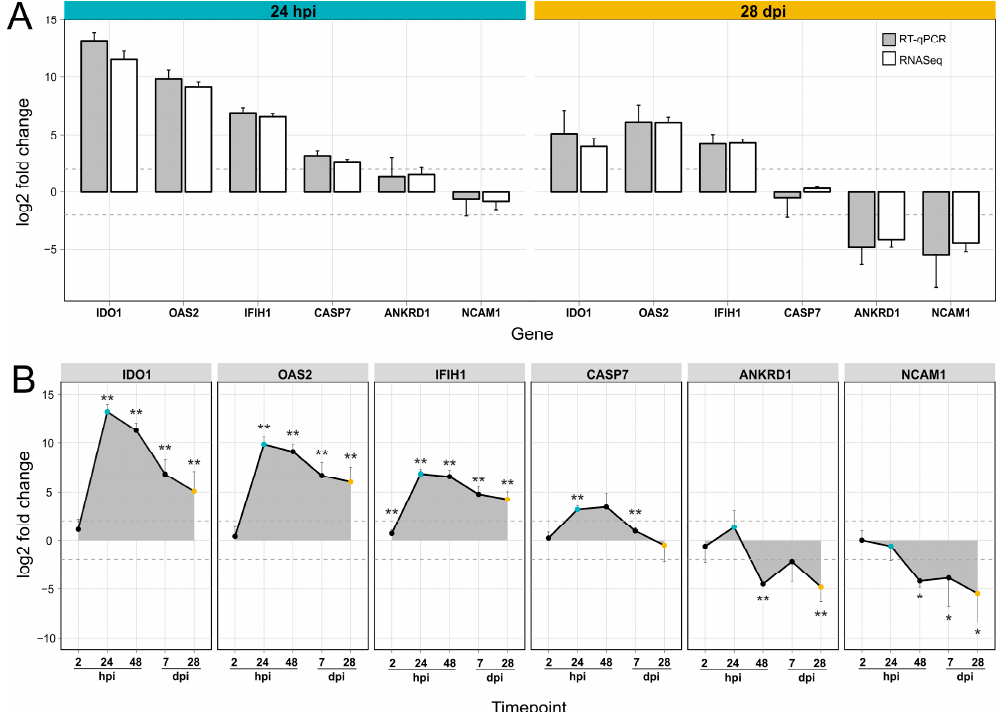
Figure 4. Expression analysis for selected genes by RT-qPCR at different time points. ( A ) Gene expression in FMDV infected soft palate cells compared to uninfected controls, at 24 hpi (blue panel) and 28 dpi (orange panel). The change in gene expression was analyzed for six selected target genes and two reference genes (not shown) using RT-qPCR. Log2 fold changes were calculated in comparison to a non-infected control from the same time points. Grey and white bars indicate the log2 fold change of gene expression using results from RT-qPCR and RNA sequencing (RNASeq), respectively. The grey dotted lines indicate a |log2 fold change| > 1. ( B ) The gene expression of the six selected genes was traced in a time course 2, 24, and 48 hpi; and 7 and 28 dpi. Statistically significant changes in comparison to control samples are highlighted with asterisks ( p -value < 0.05: *; p -value < 0.01: **). Time points 24 hpi and 28 dpi are illustrated in blue and orange, respectively.